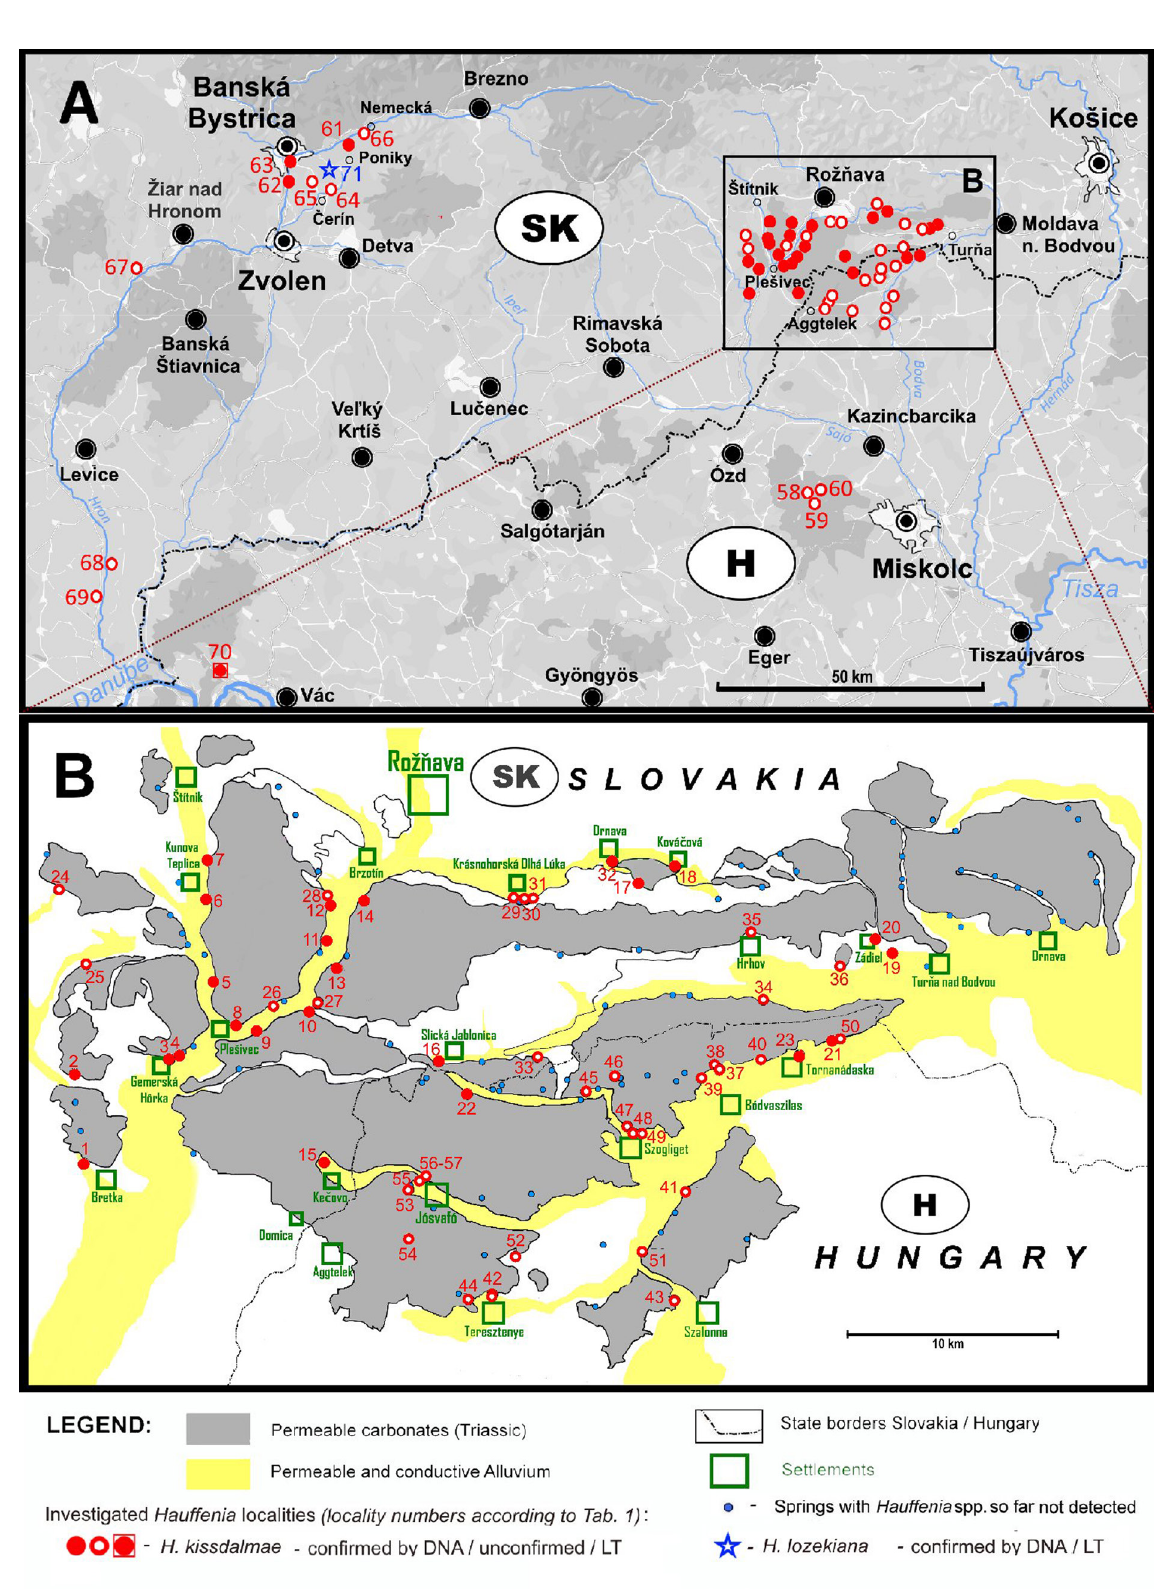
Fig. 2. Localities in Slovakia (A) and Hungary (B). Abbreviation: LT = type